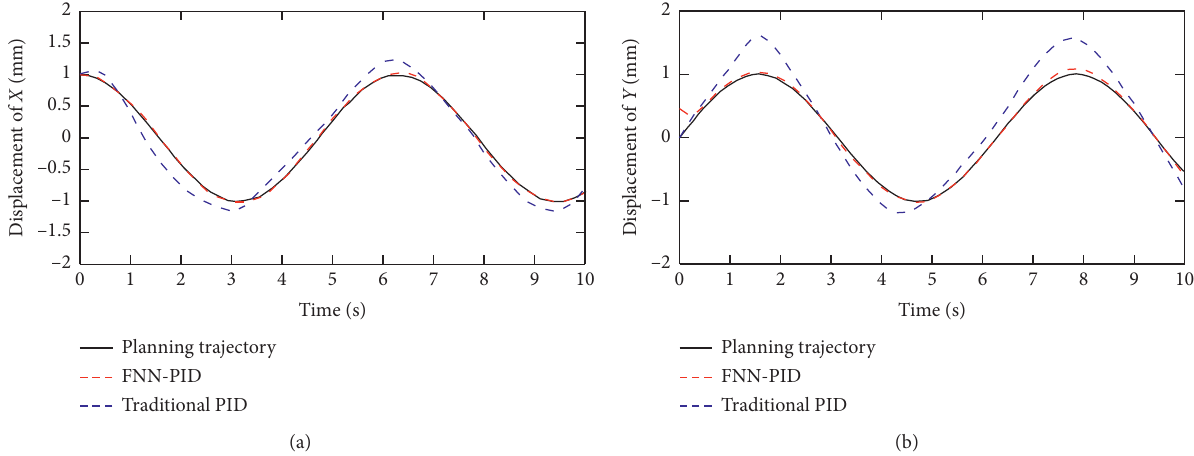
Figure 9: Displacement tracking of (a) x direction; (b) y direction.